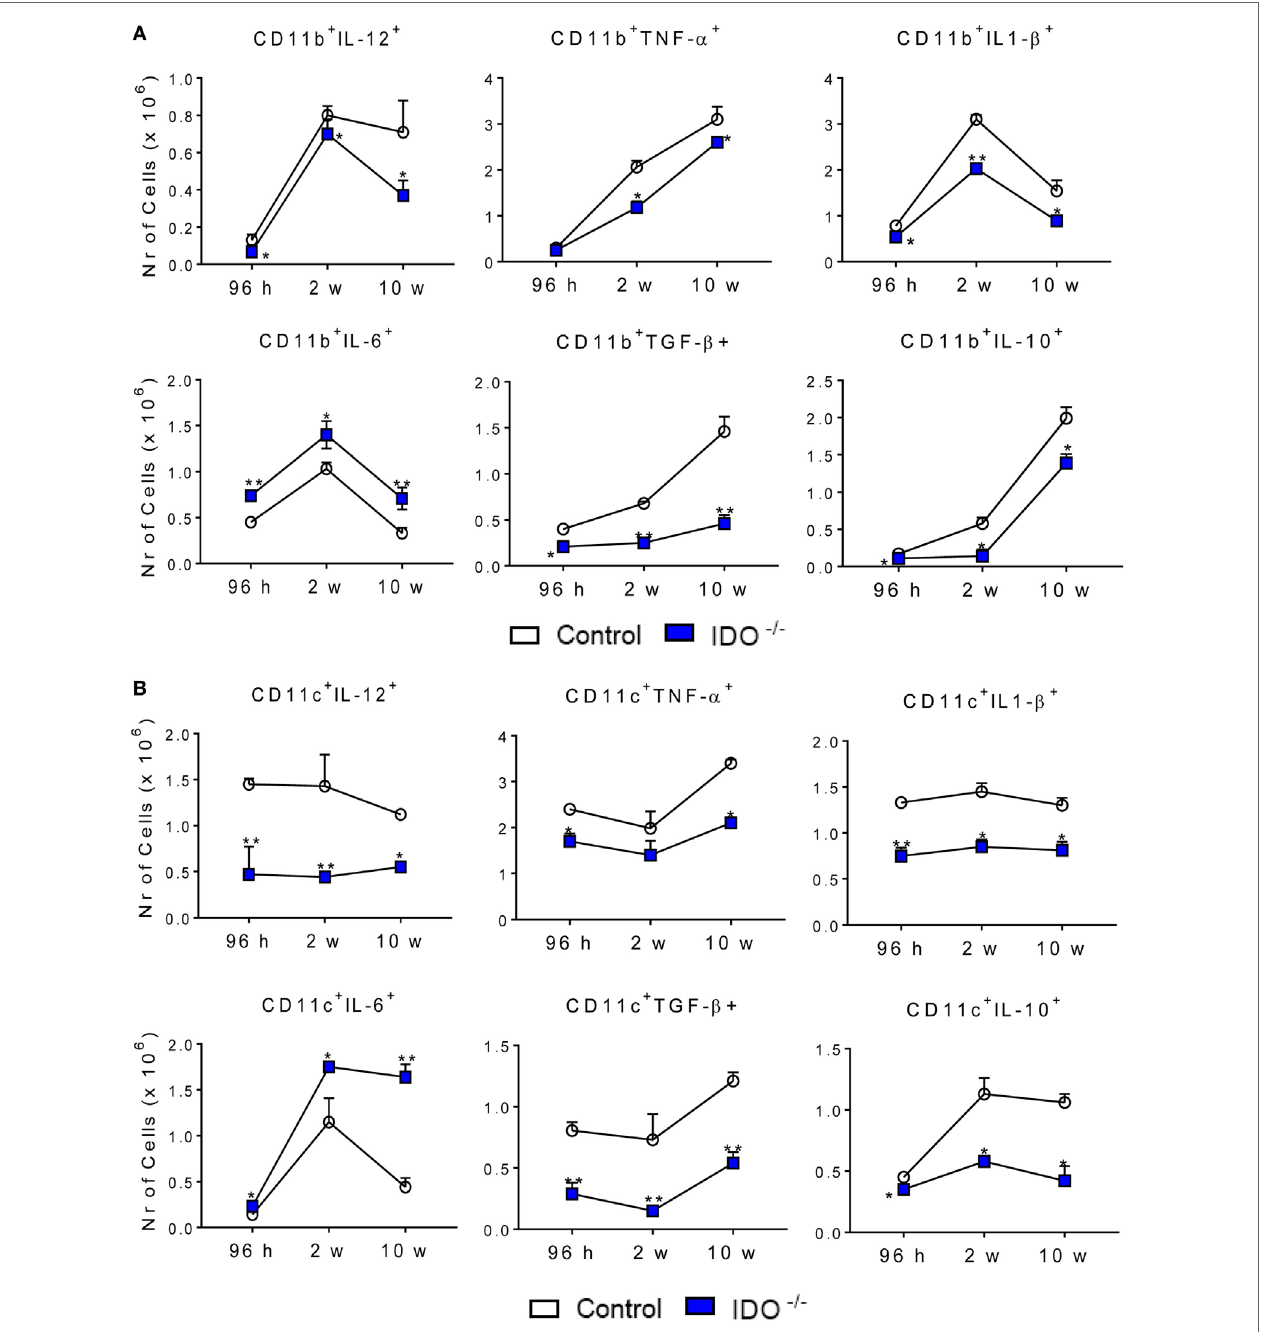
FigUre 4 | Indoleamine 2,3 dioxygenase-1 (IDO1) expression controls the presence of intracellular cytokines in pulmonary CD11b + and CD11c + cells. The intracellular cytokines were determined in CD11b + (a) and CD11c + (B) lung infiltrating leukocytes of wild-type and IDO1 − / − C57BL/6 mice after 96 h, 2, and 10 weeks of infection with 1 × 10 6 Paracoccidioides brasiliensis yeasts. The lung cells were obtained as described in Section “Materials and Methods” and labeled with antibodies conjugated to different fluorochromes. The lung infiltrating leukocytes were gated by FSC/SSC analysis. The cells were gated for CD11b + or CD11c + expression and then for the presence of cytokines IL-12, TNF- α , IL-1 β , IL-10, IL-6, and TGF- β . One hundred thousand cells were acquired on FACS CANTO II and subsequently analyzed by FlowJo software. Data are expressed as means ± SEM and are representative of three independent experiments using five mice of each mouse strain per group (* p < 0.05; ** p < 0.01, and *** p <